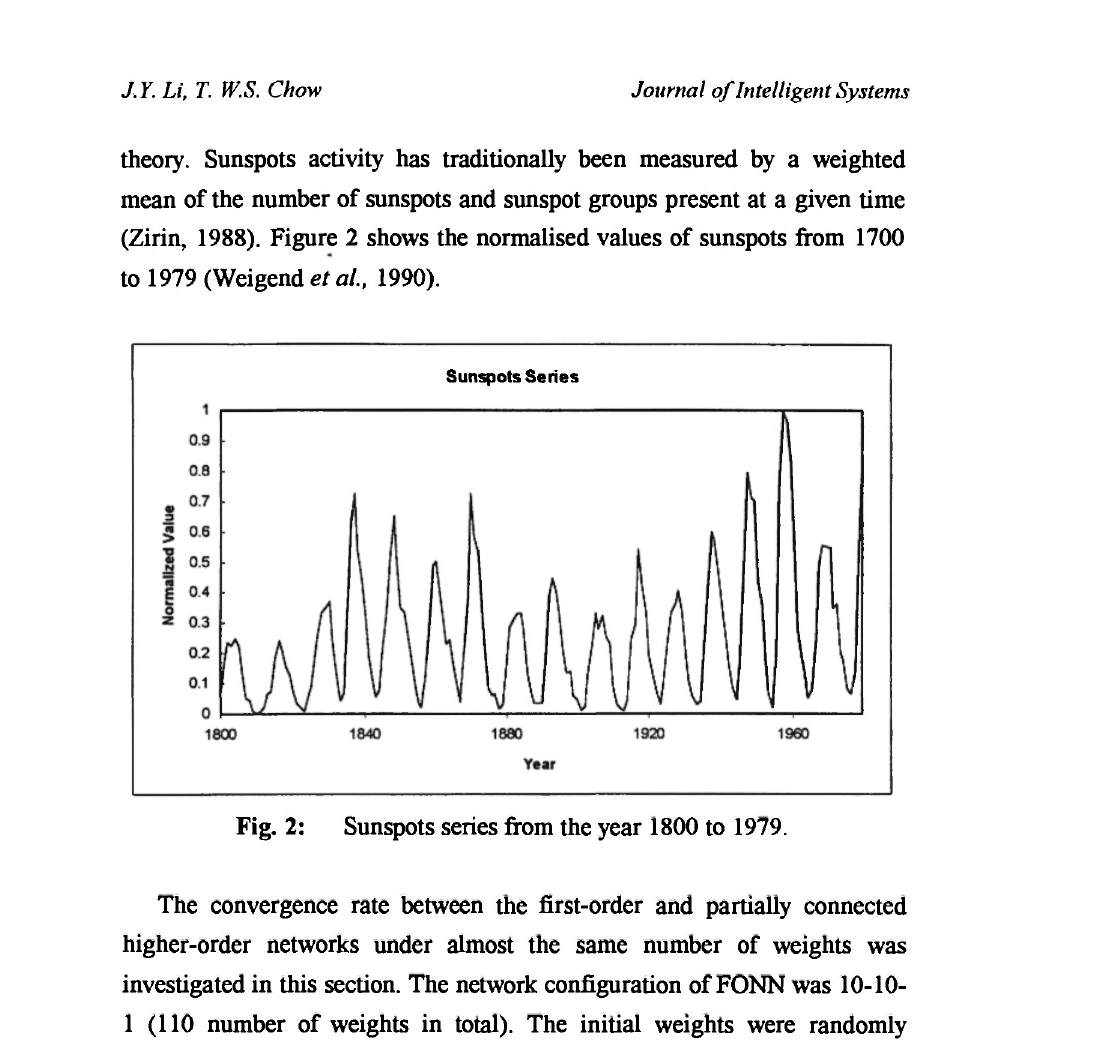
Fig. 2: Sunspots series from the year 1800 to